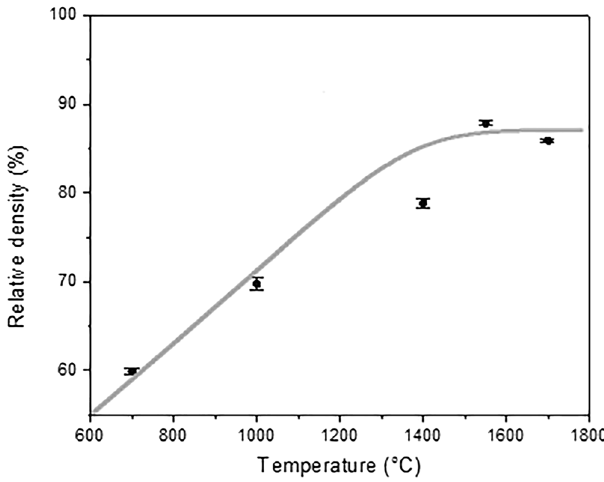
Figure 8. Evolution of the relative density of the SP-based printed cords at different